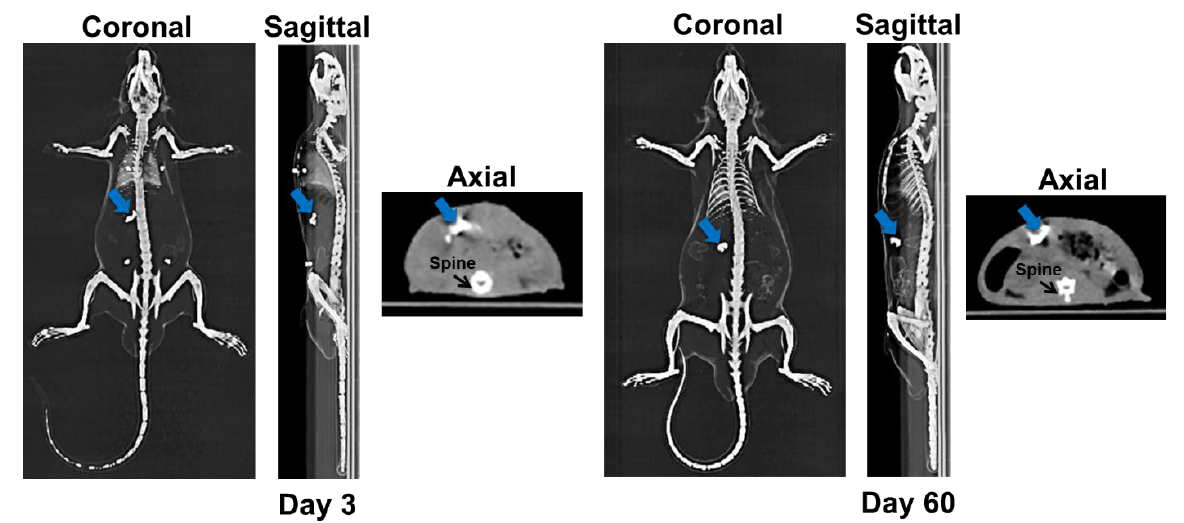
Figure 4. CT images of the rats in the study group at Day 3 and Day 60 post-injection of the [ 153 Sm]Sm 2 O 3 -PS microspheres. The blue arrow indicates the location of the microspheres.